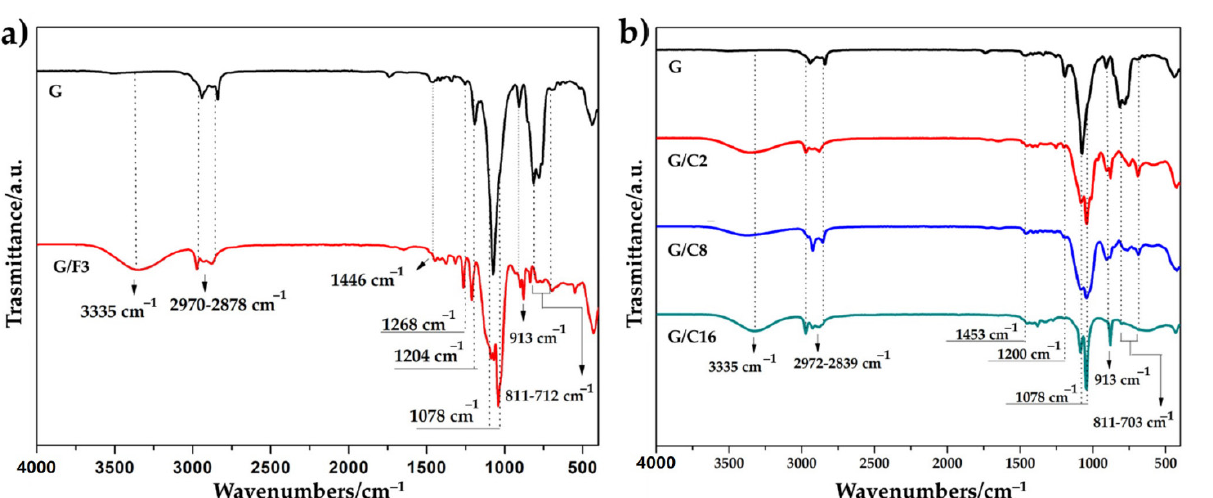
Figure 6. FT-IR spectra of glass slides treated with G and G/F3 sol ( a ) and G/C2, G/C8 and G/C16 sol ( b ).